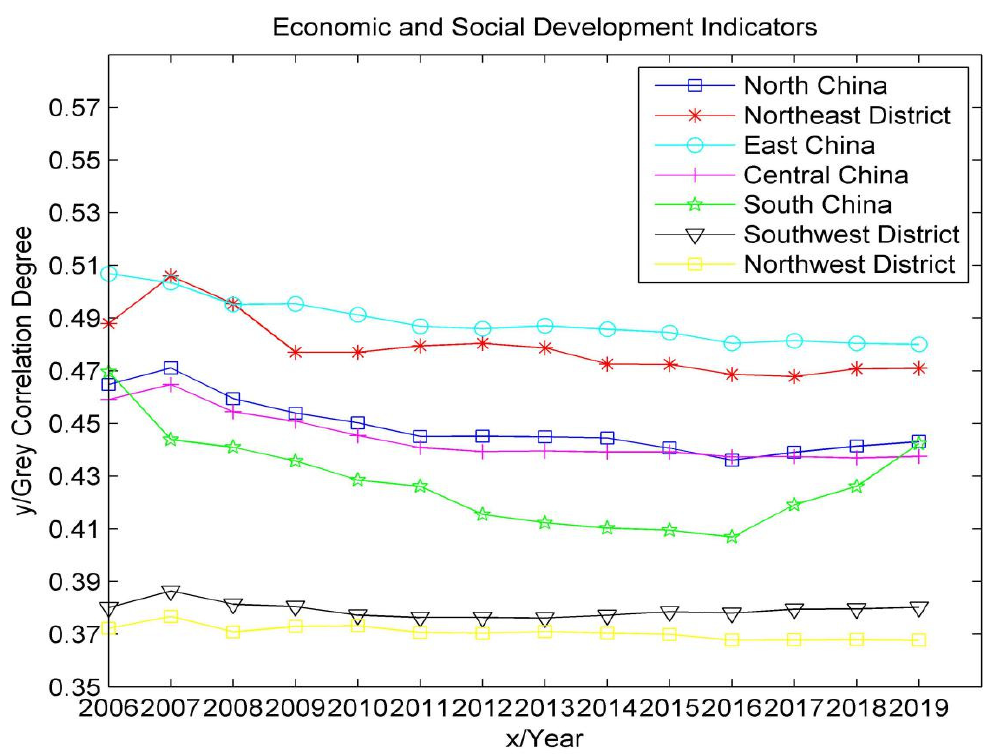
Figure 5. Time series trend of economic and social development indicators of green agriculture.